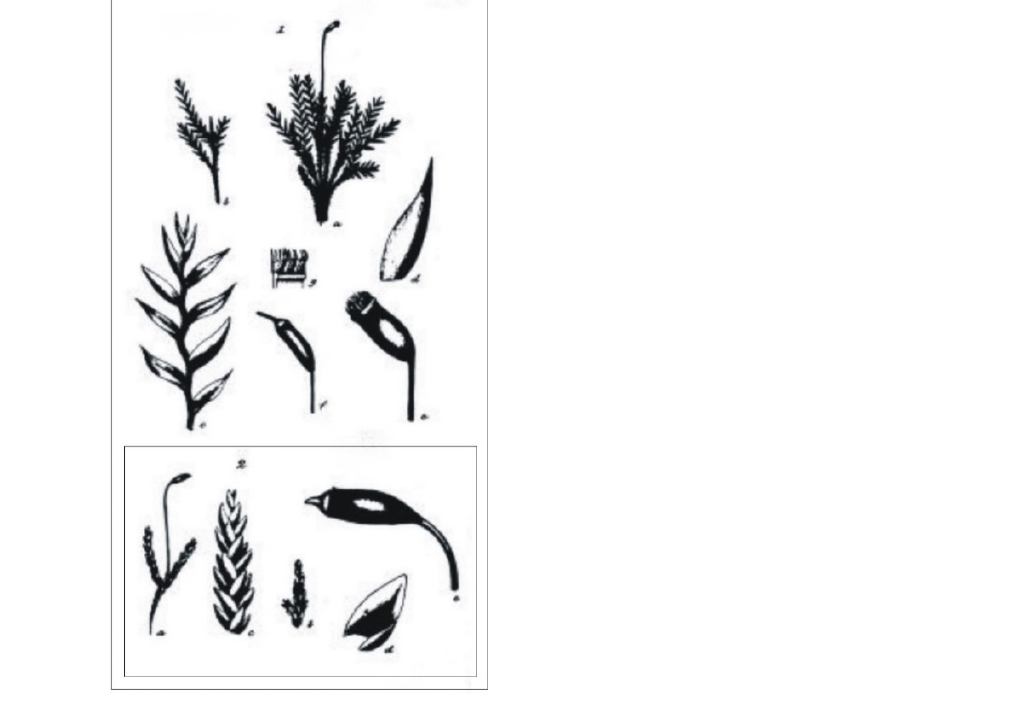
Figure 3. Original graphics from Turner’s manuscript [1]. Explanation: H . denticulatum is given in the upper part and H . denticulatum var. obtusifolium at the bottom (in the frame). Downloaded from https://archive.org (accessed on 15 April 2022).